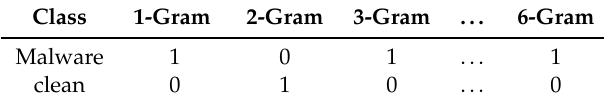
Table 2. A sample dynamic feature